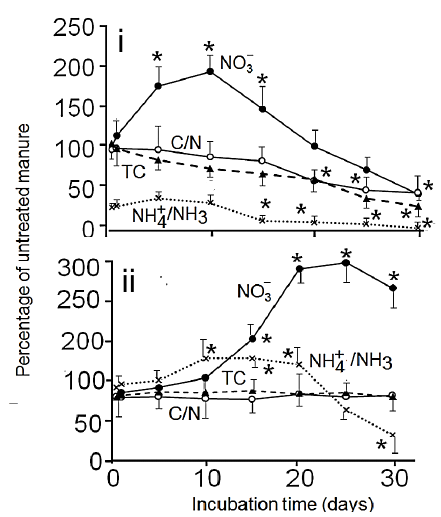
Figure 4. Effects of aerobic (i) and anaerobic (ii) incubations on time-course of change